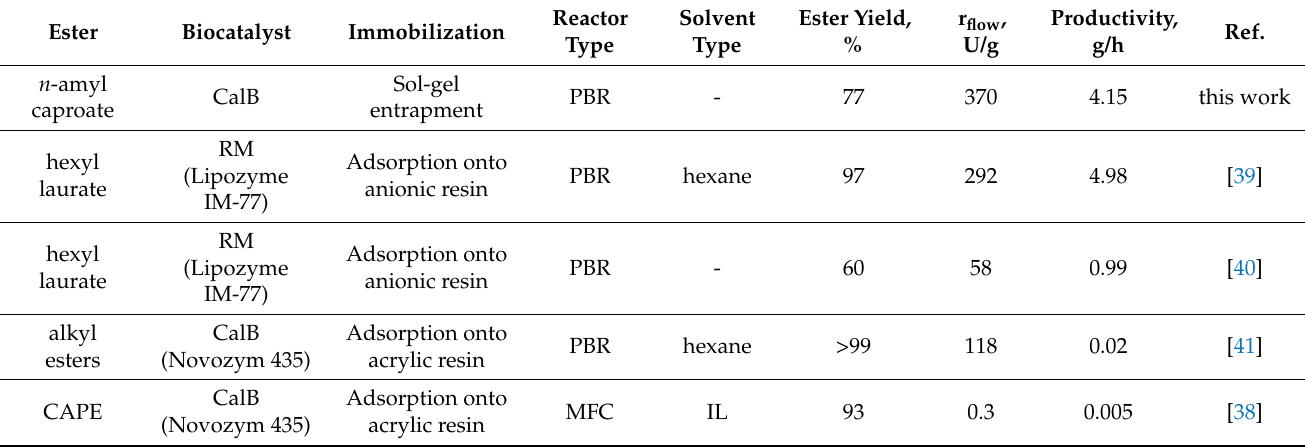
Table 6. Some examples of enzyme-catalyzed synthesis of esters in a continuous flow